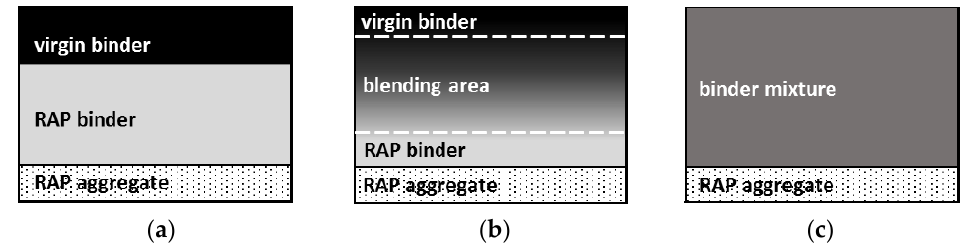
Figure 1. Distribution of virgin binder and RAP binder to the thickness of the binder film depending on the blending degree: ( a ) no blending, ( b ) partial blending, ( c ) full blending [7].